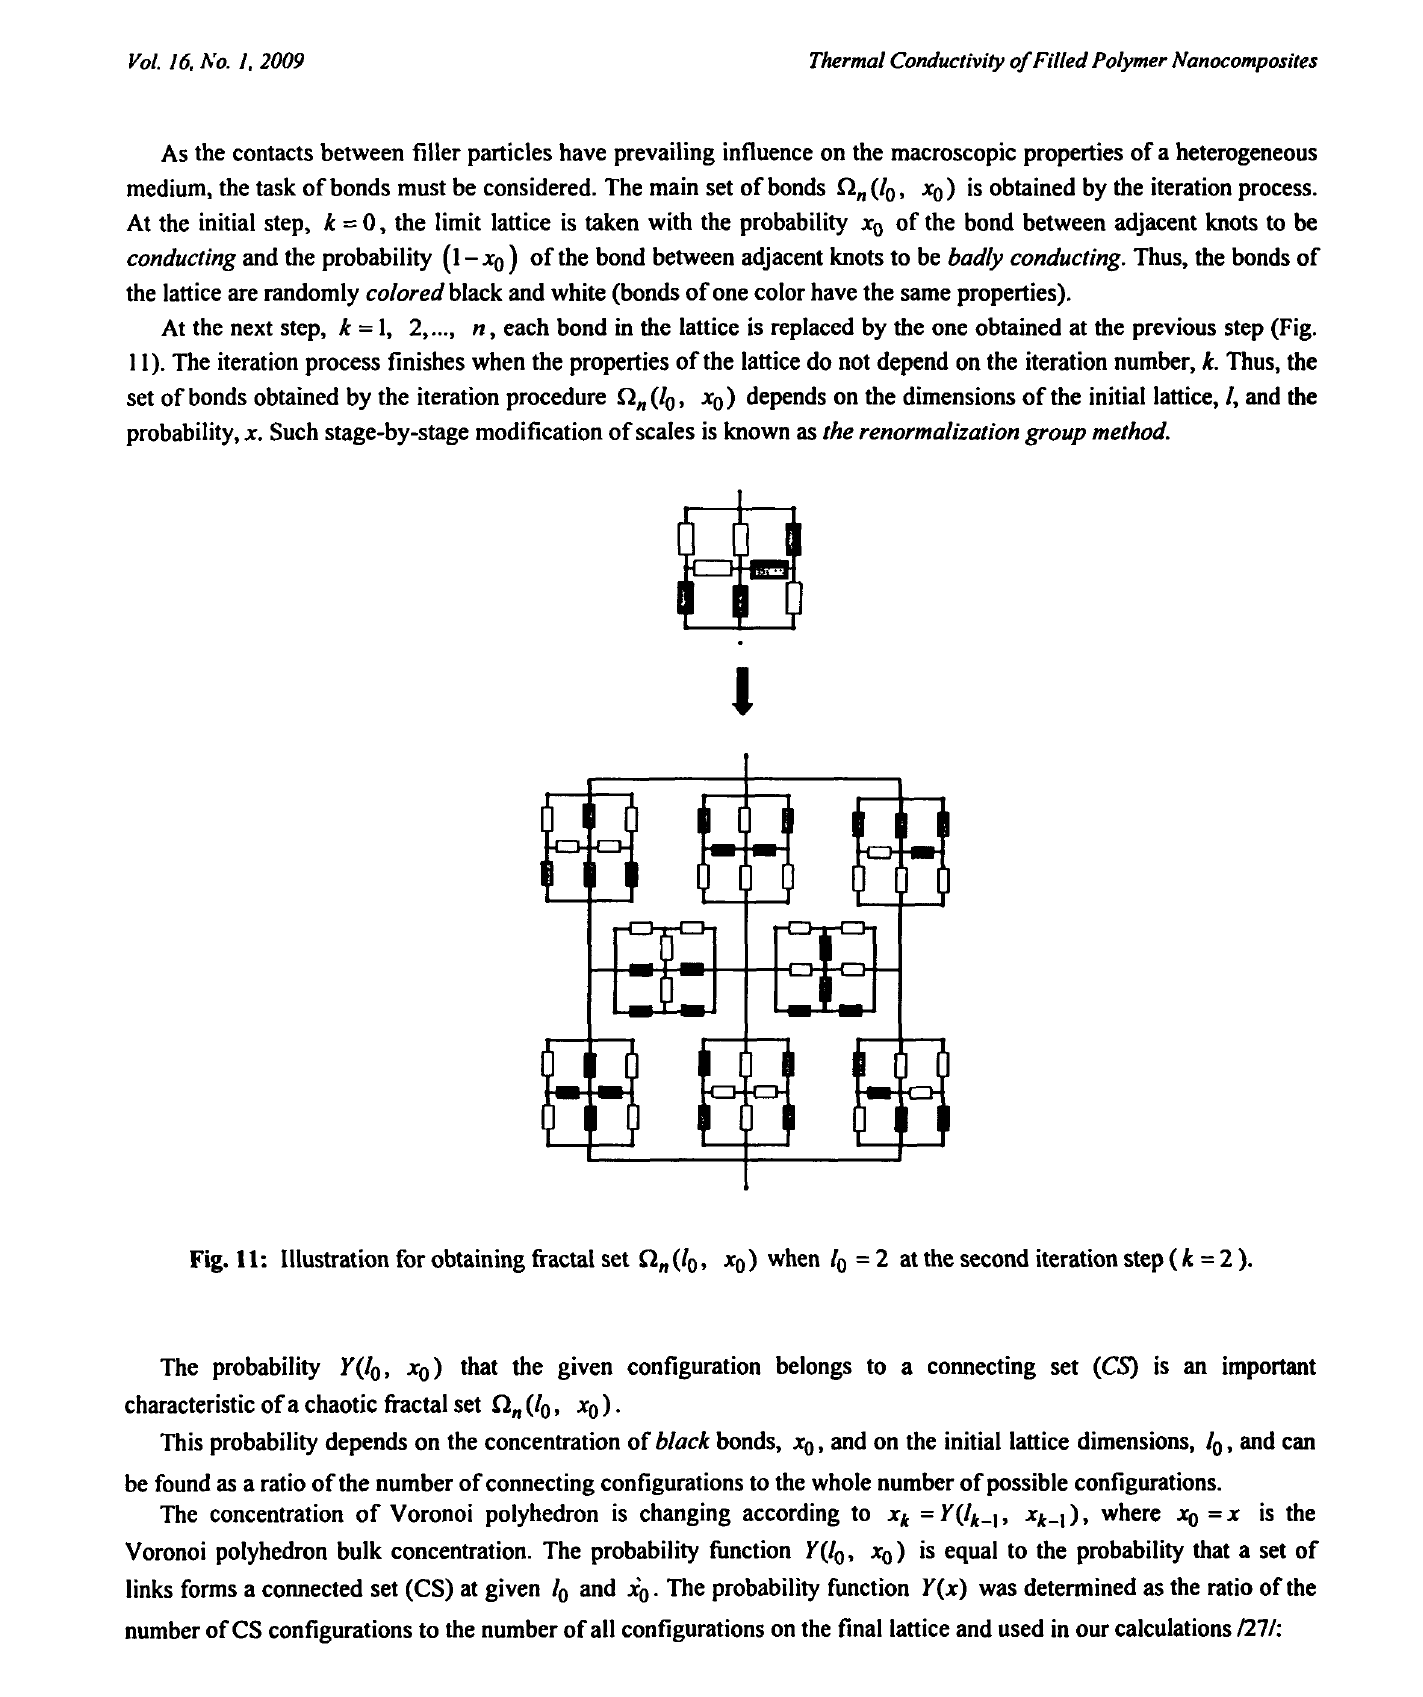
The probability K(/ characteristic of a chaotic fractal set Ω